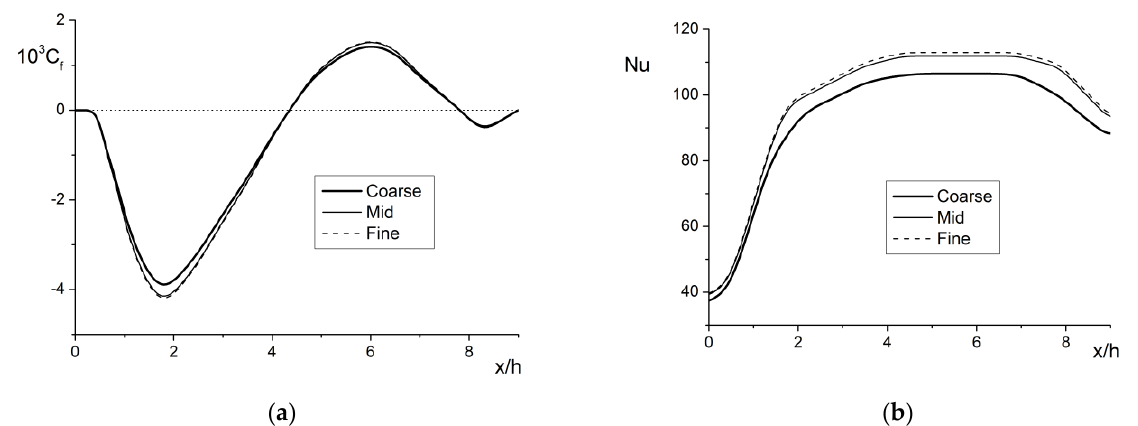
Figure 3. Grid independence test for the wall friction ( a ) and heat transfer ( b ) distributions along the duct length. M L 1 = 5%, d 1 = 15 µm, Re = HU m 1 / ν = 1.6 × 10 4 . duct length. M L 1 = 5%, d 1 = 15 µ m, Re = HU m 1 / ν = 1.6 × 10 4